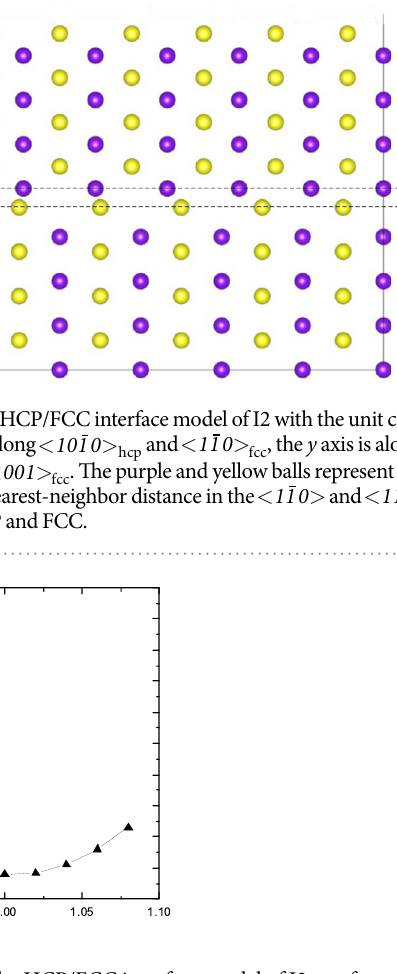
Figure 6. Energy difference ( Δ E) of the HCP/FCC interface model of I2 as a function of d1/d2 with respect to the total energy of I2 before volume expansion (d1/d2 = √ 3/2). d1 and d2 are the nearest-neighbor distance in the < > 110 and 110 < > directions,